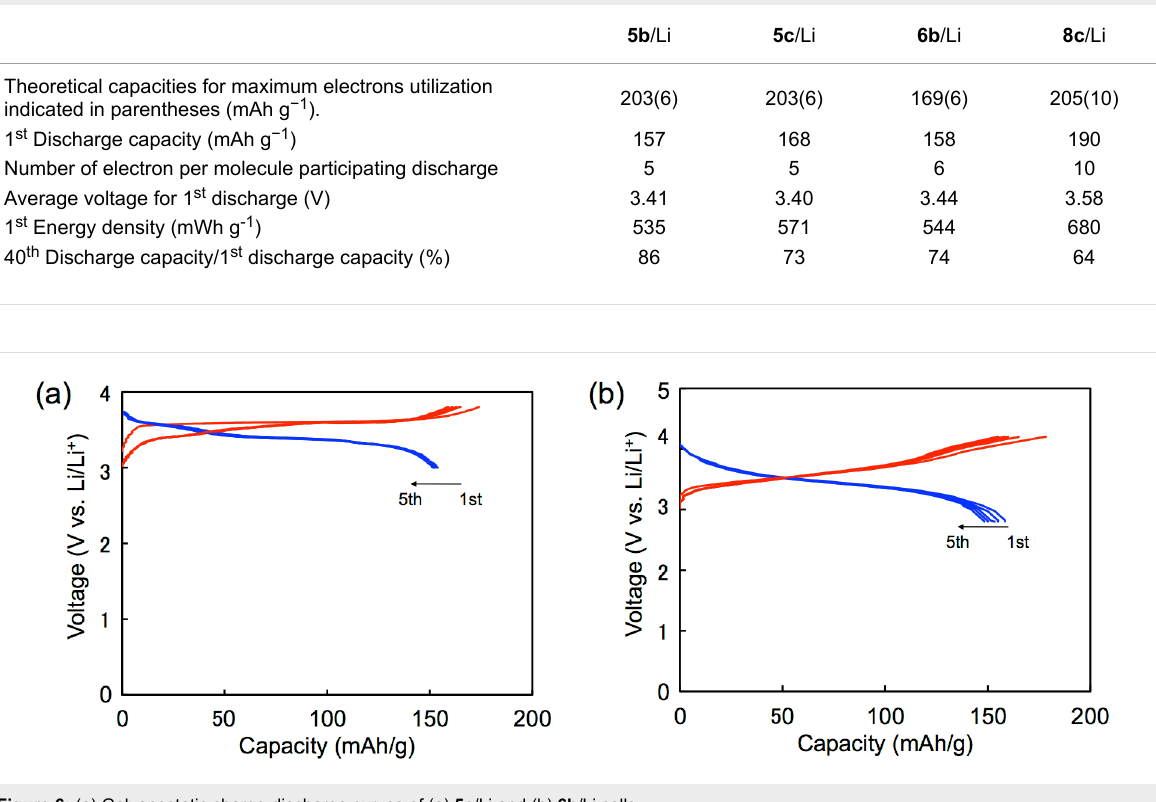
Figure 6: (a) Galvanostatic charge-discharge curves of (a) 5c /Li and (b) 6b /Li